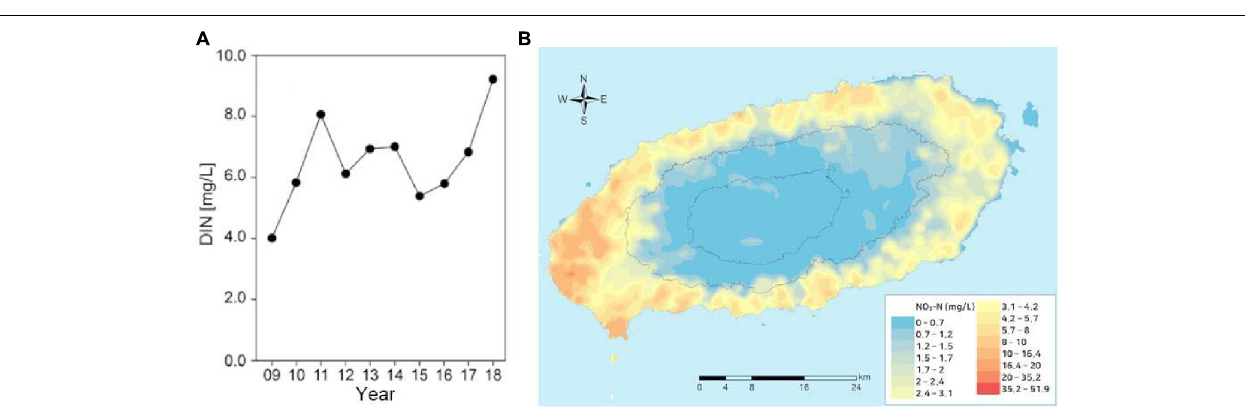
agricultural activities in the spring season. However, the trend of DSi was similar to that of the FSGD, indicating that the DSi was a reliable tracer for